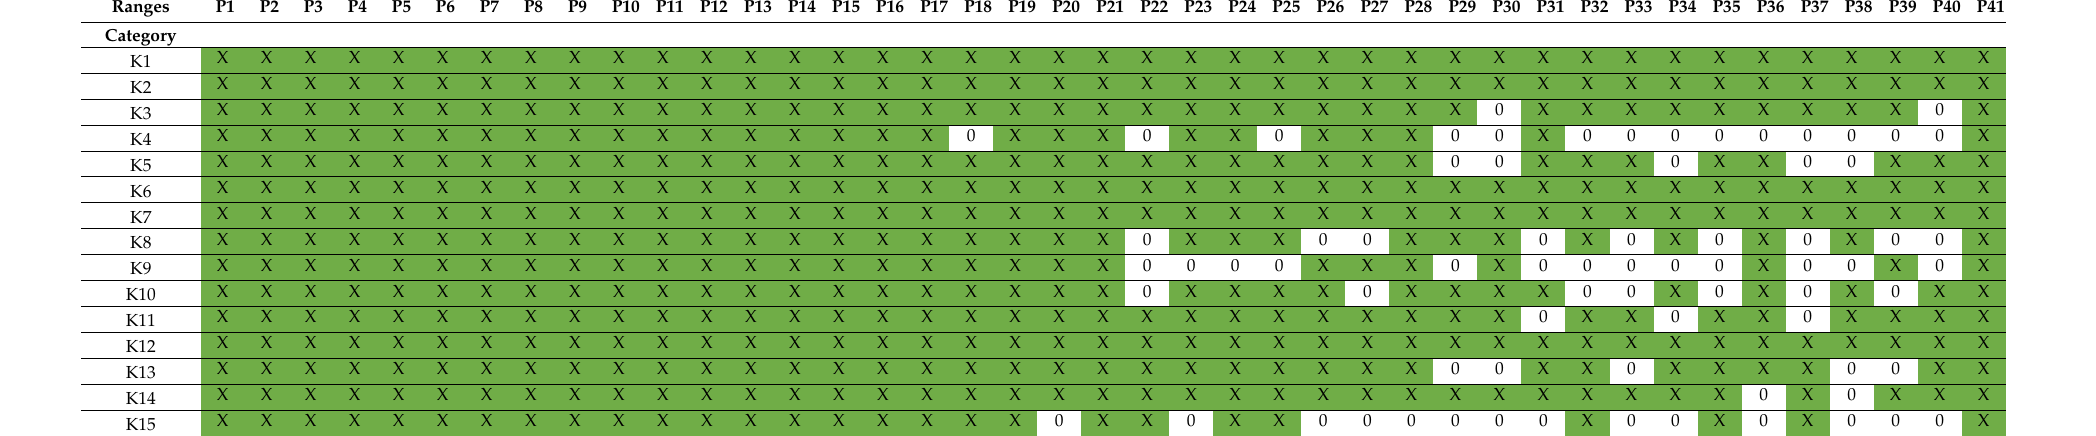
Table 11. KA matrix, in terms of project categories according to